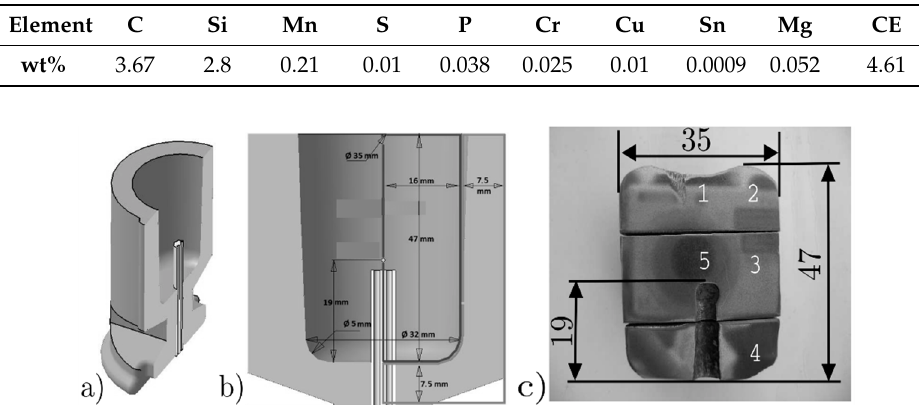
Figure 4. Sampling cup in which the molten metal was poured. ( a ) A 3D perspective of half section of the cup. ( b ) Front view of the cup with the thermocouple and the bifilar. ( c ) Longitudinal view of the specimen: its dimensions are indicated (in mm) and five zones numbered, which were microstructurally characterized.